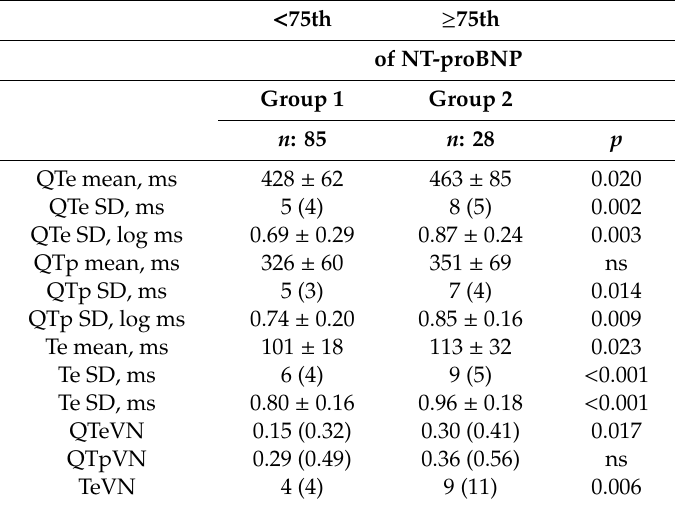
Table 2. Short period repolarization temporal dispersion variables in study patients.